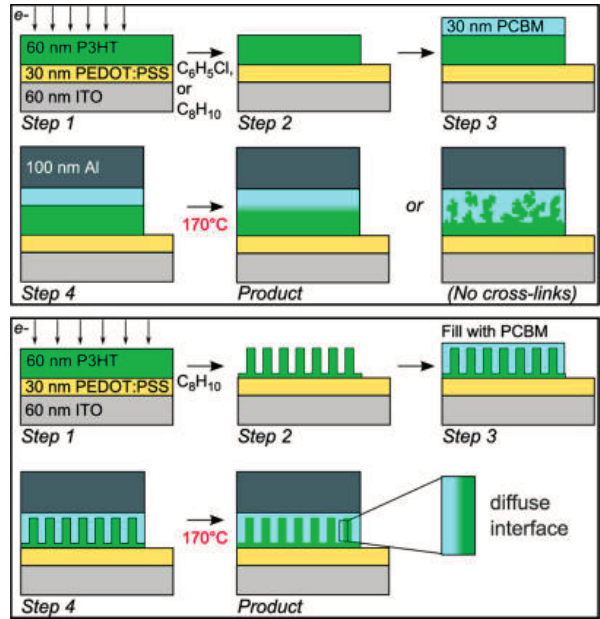
Figure 8. Direct patterning of gradient ( top ) and nanostructured ( bottom ) polymer/fullerene solar cells. ITO (indium tin oxide); PEDOT:PSS (poly(3,4-ethylenedioxythiophene): poly-(styrenesulfonate)); P3HT (poly(3-hexylthiophene), PCBM ((6,6)-phenyl-C acid methyl ester). PCBM is spin-cast from dichloromethane (DCM). Cited from [94].